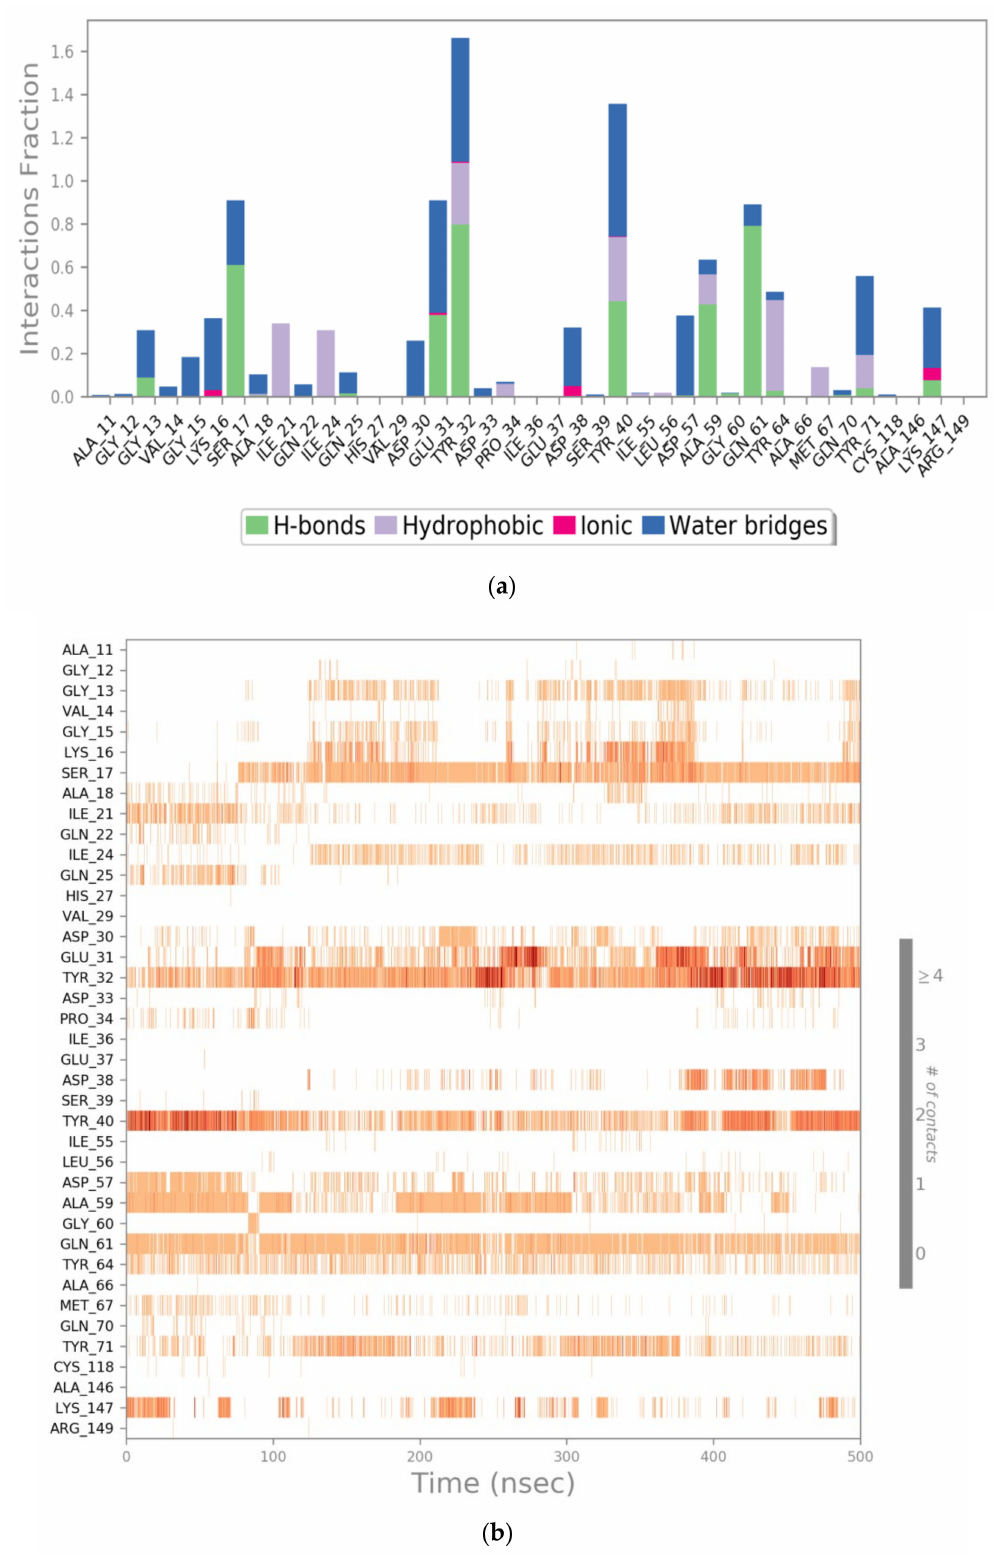
Figure 7. ( a ) Histogram of the interactions established between the Ras protein binding region and the 3 10 -HBS RB3 peptide; ( b ) Plot illustrating the frequency of interaction occurrences between the Ras protein binding region and the 3 10 -HBS RB3